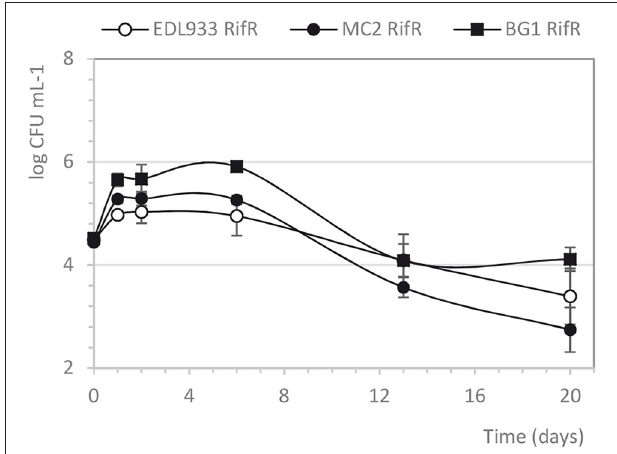
FIGURE 3 | Growth curves of E. coli strains incubated in unfiltered bovine feces. Cultures were incubated in feces samples at 15 ◦ C without shaking. Each time point is the mean of three independent